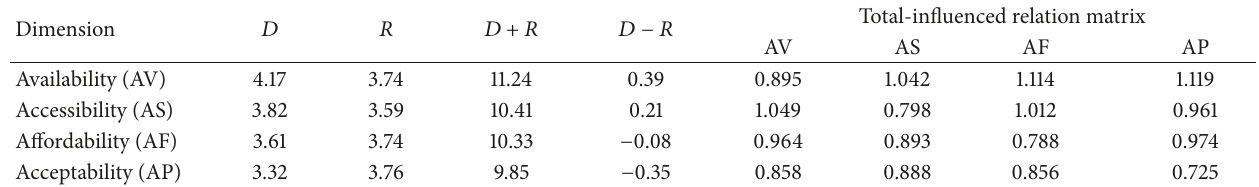
Table 10: The result of Fuzzy-DEMATEL analysis for 4As (Case 1 ).